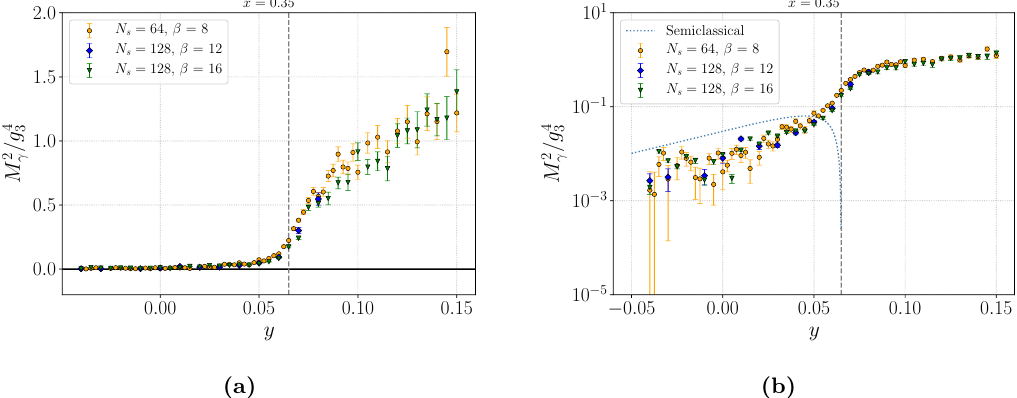
Figure 5 . (a): Square of the photon mass in physical units. The vertical dashed line at y c = 0 . 065 shows the approximate crossover point. (b): Same as (a) but on a logarithmic scale and showing also the semiclassical expectation, eq. (2.5), shifted to start at y c .